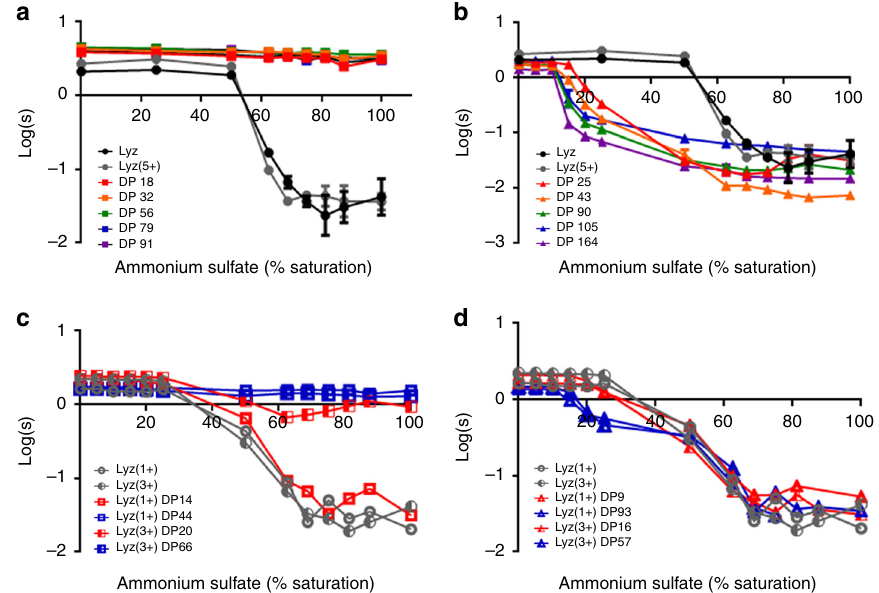
Fig. 2 Ammonium sulfate precipitation of conjugates. a , b Native Lyz, Lyz(5 + ), and Lyz – polymer conjugates. Plots are solubility (log of the supernatant protein concentration) versus ammonium sulfate percent saturation. 100% saturation corresponds to 4.1 M salt concentration. a Lyz(5 + )pCBMA conjugates with DP 18, DP 32, DP 56, DP 79, and DP 91. b Lyz(5 + )pOEGMA conjugates with DP 25, DP 43, DP 90, DP 105, and DP 164. pCBMA increased Lyz ’ s solubility while pOEGMA decreased Lyz ’ s solubility depending on DP. c , d Ammonium sulfate precipitation of native Lyz(1 + ), Lyz(3 + ), and Lyz – polymer conjugates with lower grafting densities and low/high DP. c pCBMA conjugates of Lyz(1 + ) DP 14, Lyz(1 + ) DP 44, Lyz(3 + ) DP 20, and Lyz(3 + ) DP 66. The only pCBMA conjugate that precipitated was the lowest grafting density and lowest DP. d pOEGMA conjugates of Lyz(1 + ) DP 9, Lyz(1 + ) DP 93, Lyz(3 + ) DP 16, and Lyz(3 + ) DP 57. pOEGMA length affected solubility more than grafting density. Error bars represent the standard deviations from triplicate measurements ( n =